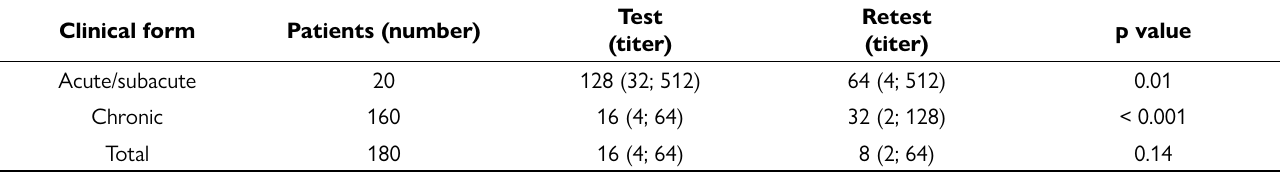
Table 2. Titers of specific serum antibodies determined by double agar gel immunodiffusion test, in samples from 20 patients with the acute/subacute form and 160 with the chronic form of paracoccidioidomycosis. Comparison of the titers determined at the moment of blood draw (test) and after at least six months of